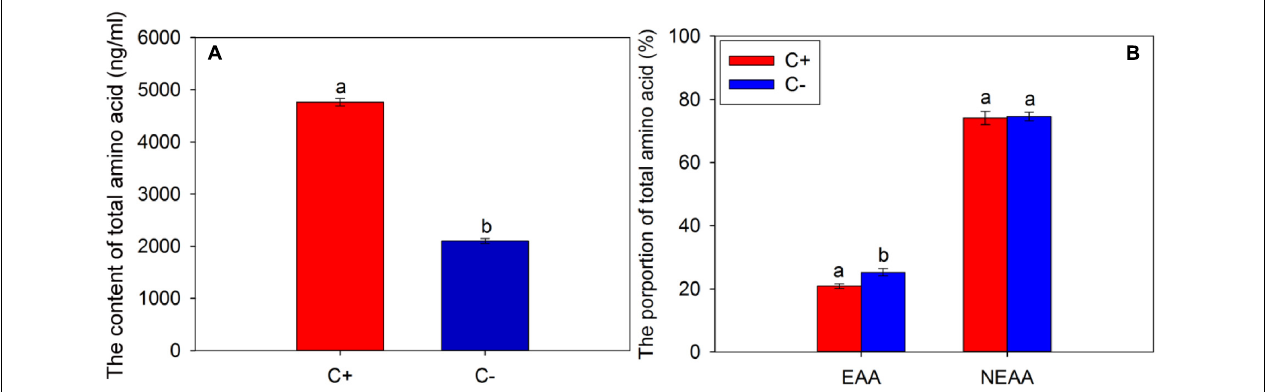
FIGURE 1 | The contents of a total amino acid (A) and the proportions of essential amino acids (EAAs) and non-essential amino acids (NEAAs) (B) in the phloem sap of citrus plants. “C+” and “C − ” represent Candidatus Liberibacter asiaticus ( C Las)-infected and C Las-free citrus plants, respectively; EAA, essential amino acid; NEAA, non-essential amino acid. Values are represented as mean ± SE, and different letters over the bars mean significant differences between groups at P <